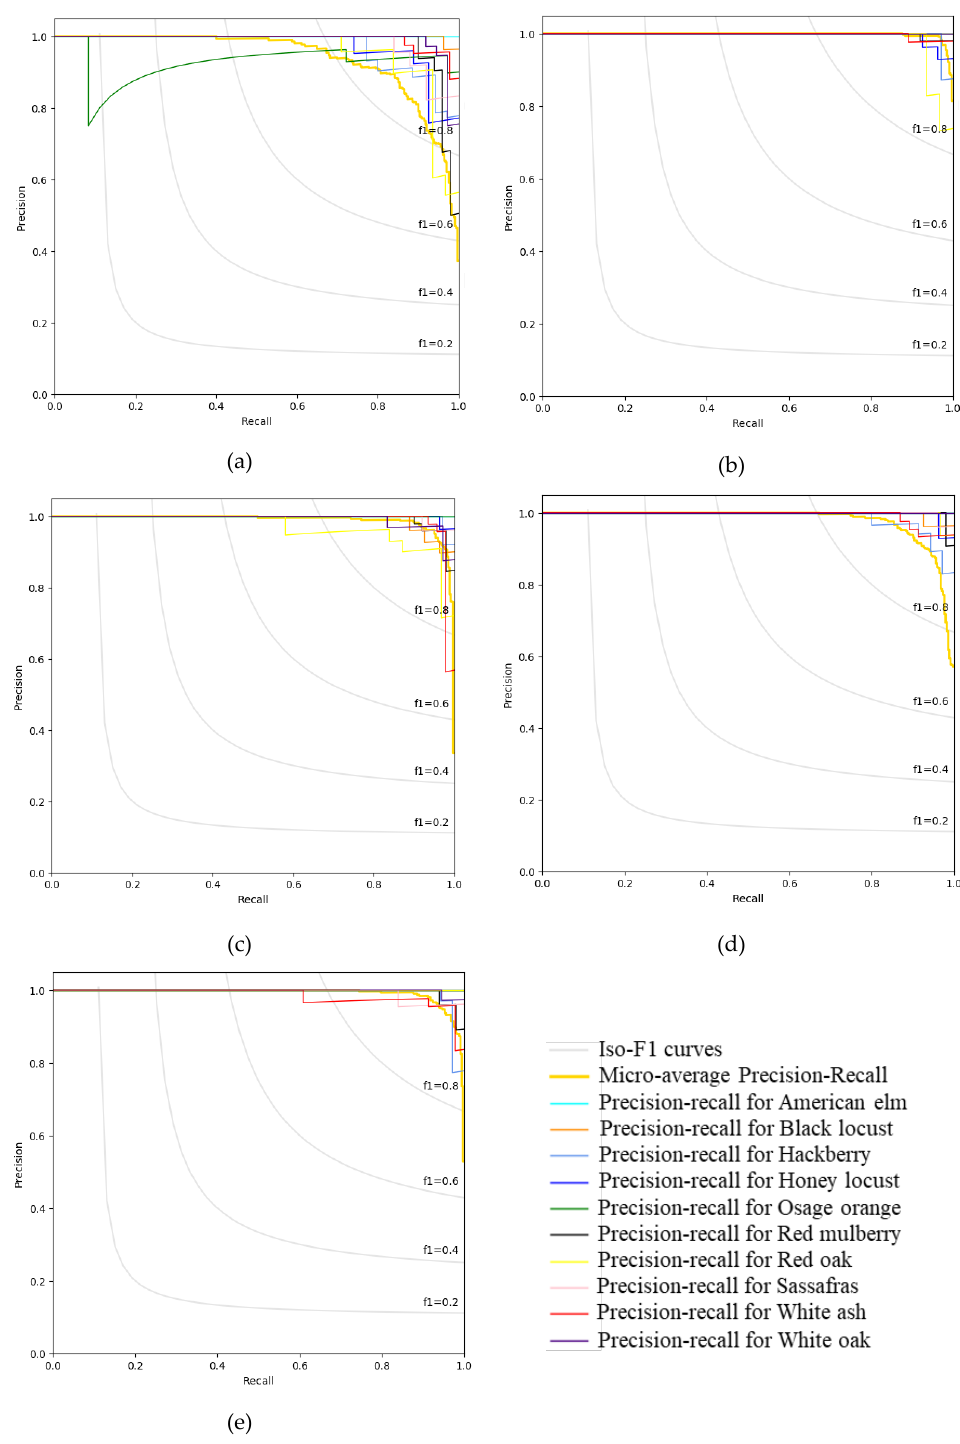
Figure 5. Precision–recall curves (PRC) for di ff erent isometric F1 curves for ( a ) Fold 1; ( b ) Fold 2; ( c ) Fold 3; ( d ) Fold 4; and ( e ) Fold